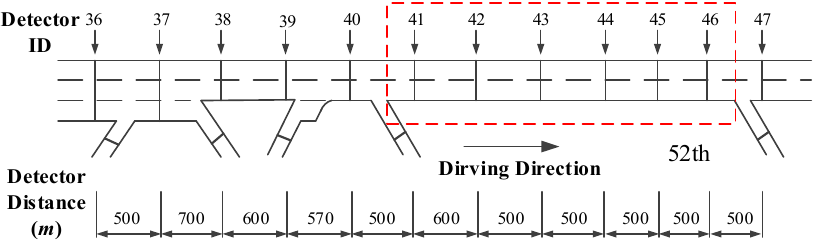
Figure 5. Layout of detectors on the 52nd segment.